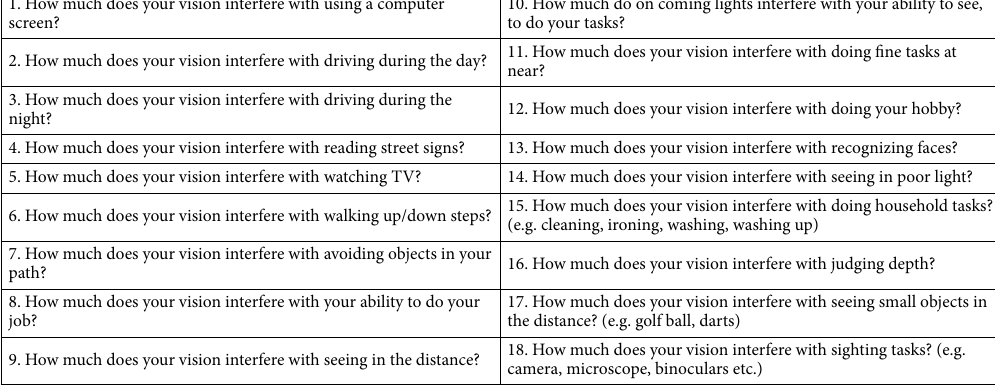
Table 1. KORQ questionnaire Part I—Activity limitation. KORQ Keratoconus Oucomes Research Questionnaire.